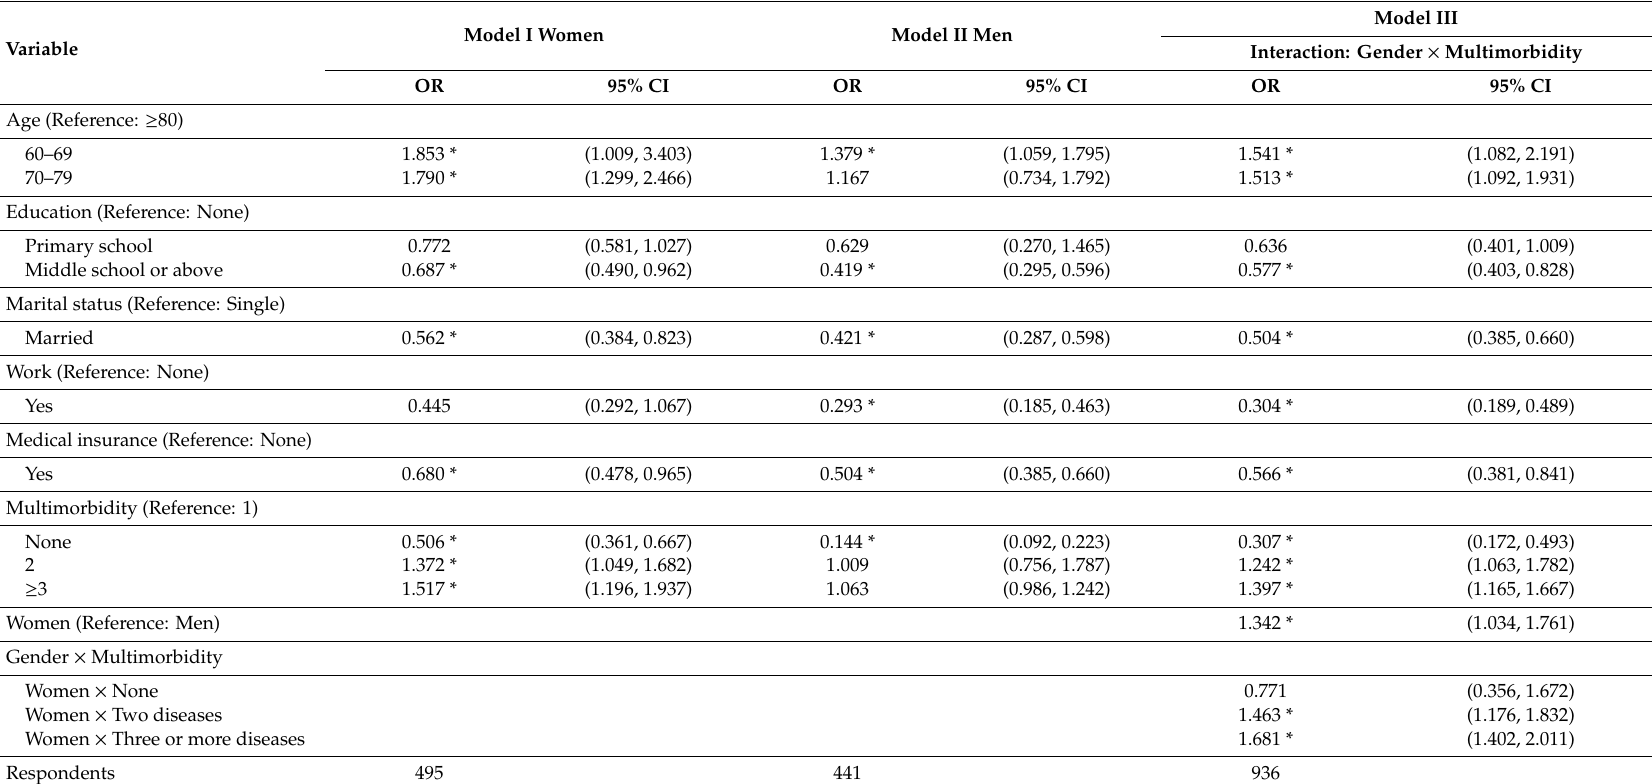
Table 3. Multivariable linear regression models for association between multimorbidity status and mental health and its gender di ff